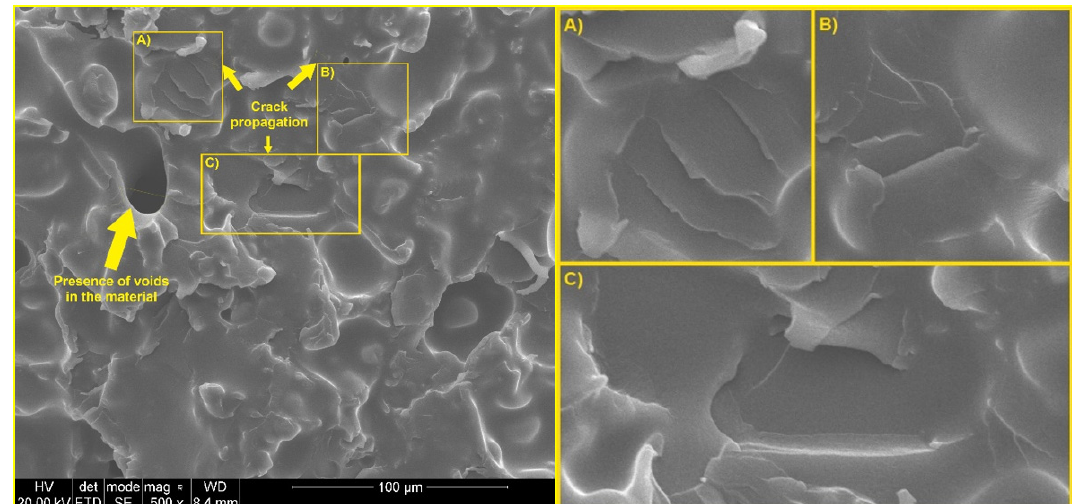
Figure 7. Scanning electron microscopy (SEM) images of the matrix.